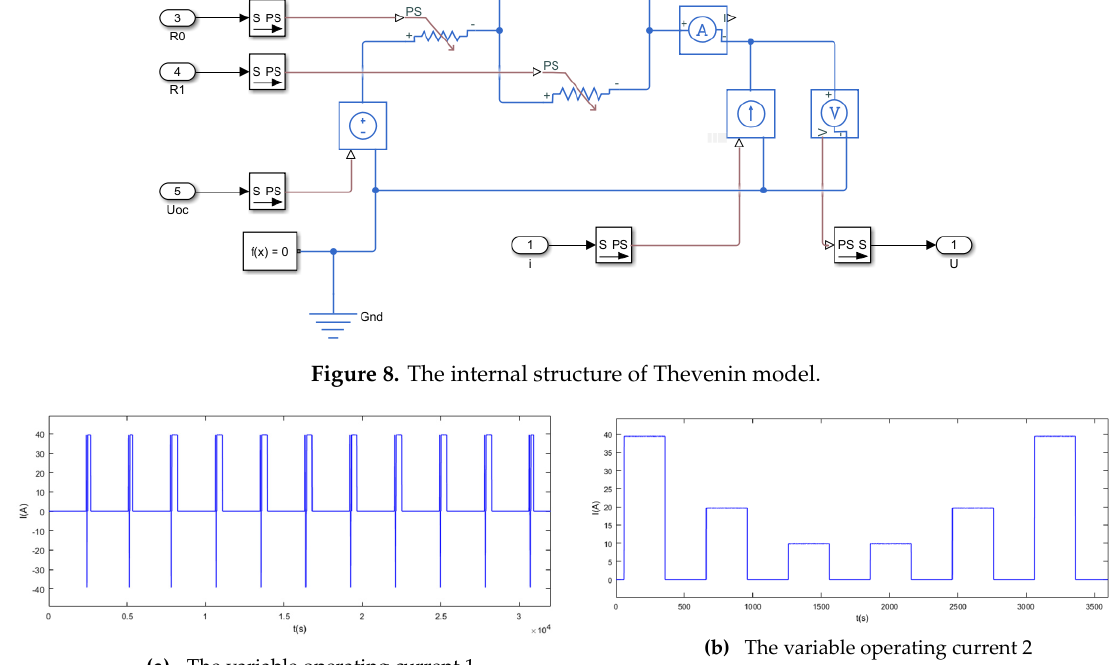
Figure 7. The internal structure of ampere-hour ( AH) integral.